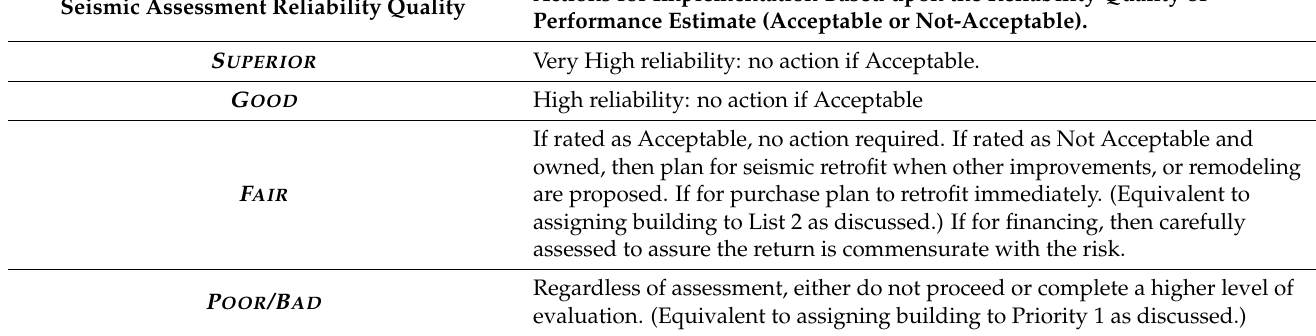
Table 7. Proposed decision matrix for how to act upon the assessed confidence in the reliability of assigned seismic performance level of the building. These requirements are for the CBC occupancy Seismic Category I, II and III. See text for the descriptions of the Lists. The option always exists to delay determination of how to proceed by commissioning a more complete seismic